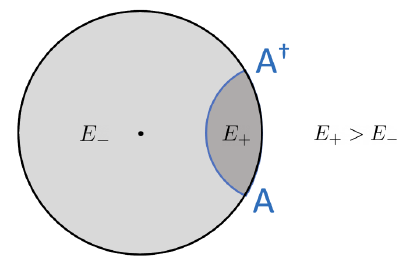
Figure 2 . Single shell solution. We suppressed the S d − 1 , only the Euclidean time and radial directions are indicated here. The dot at the center indicates a fixed point of the U (1)